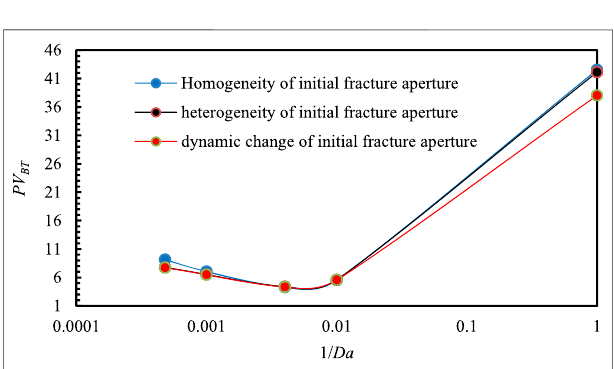
FIGURE 10 | In fl uence of homogeneity of initial fracture aperture, of the heterogeneity of initial fracture aperture, and the changing of fracture aperture on the breakthrough volume of injected